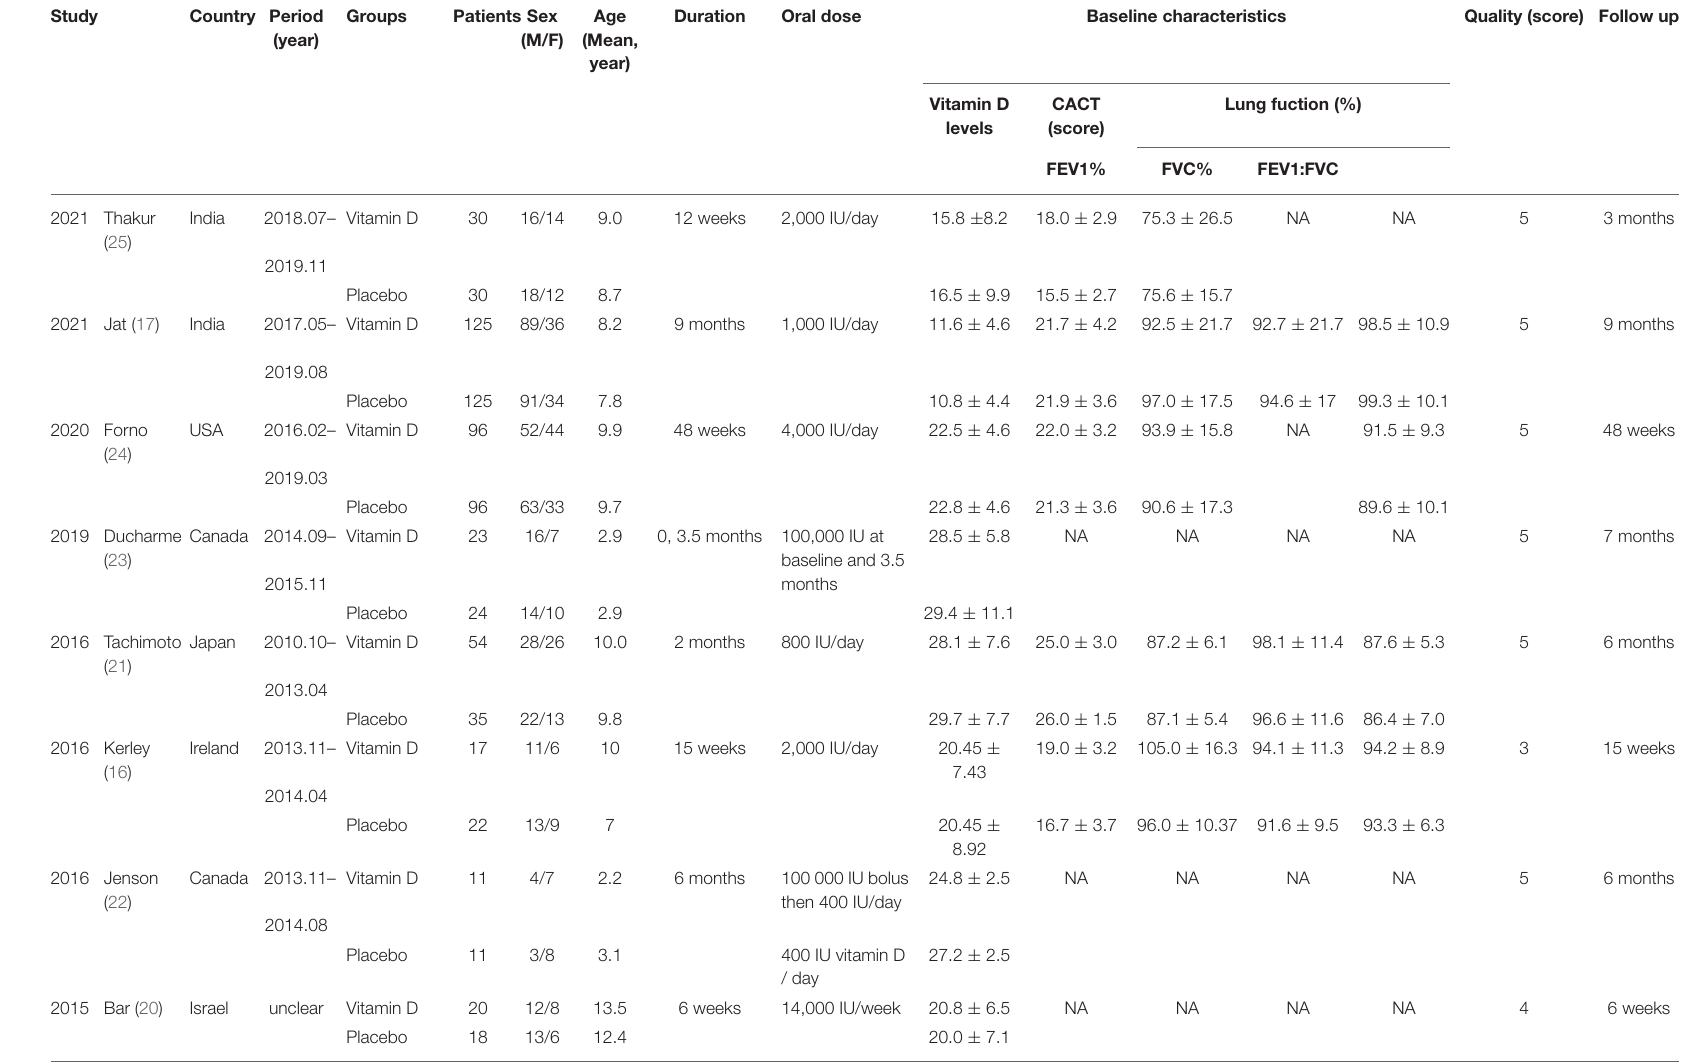
TABLE 1 | Summary of the baseline characteristics of the included studies.